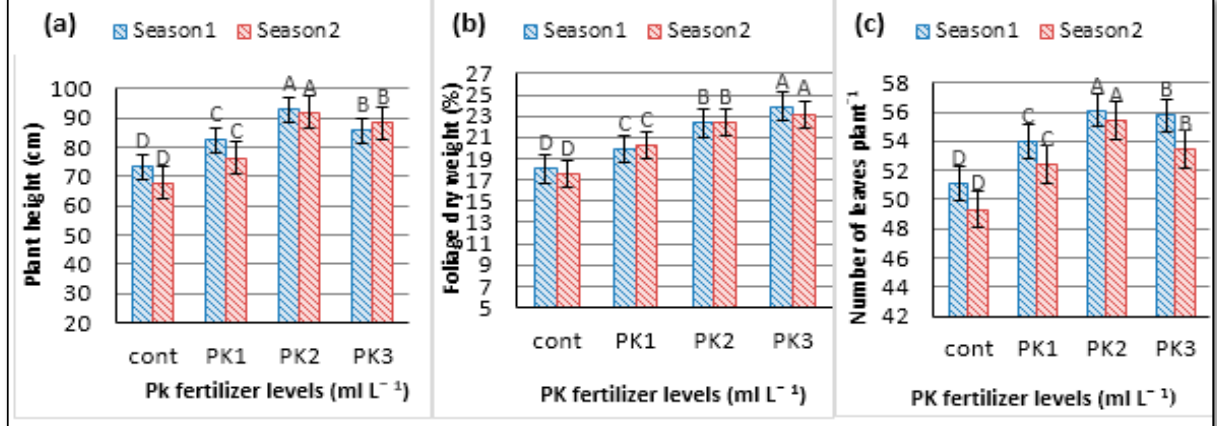
Figure 1. Vegetative growth parameter (means ± SE) of the globe artichoke as affected by the application of PK fertilizer levels (Control: without, PK 1 : 25, PK 2 : 50 and PK 3 : 75 mL L − 1 ) on ( a ) Plant height (cm); ( b ) Foliage dry weight (%) and ( c ) Number of leaves per plant. Letters in the figures indicate that the mean ± SE treatments with the same letters were not significantly different according to Duncan’s multiple range test for p < 0.05.